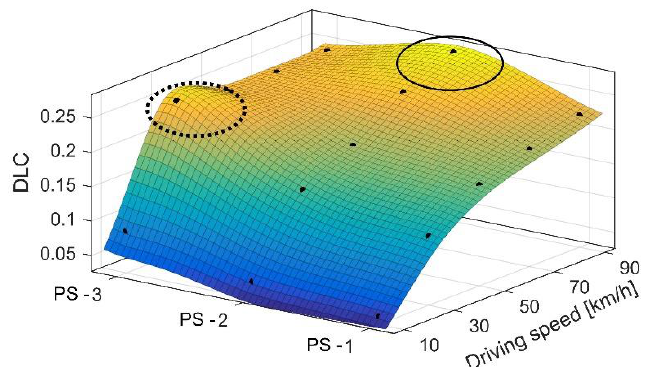
Figure 7. The estimated DLC at different driving speeds and investigated pavement states.